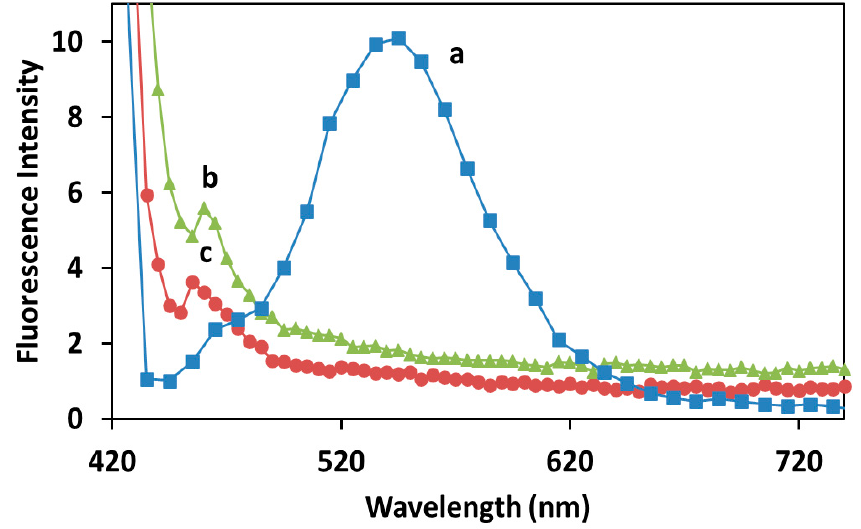
Figure 7. Fluorescence intensity emission of ( a ) curcumin alone, ( b ) Cur-AgNPs before dialysis and ( c ) Cur-AgNPs after dialysis. The most representative experiment among the five different batches produced with this synthesis is shown.